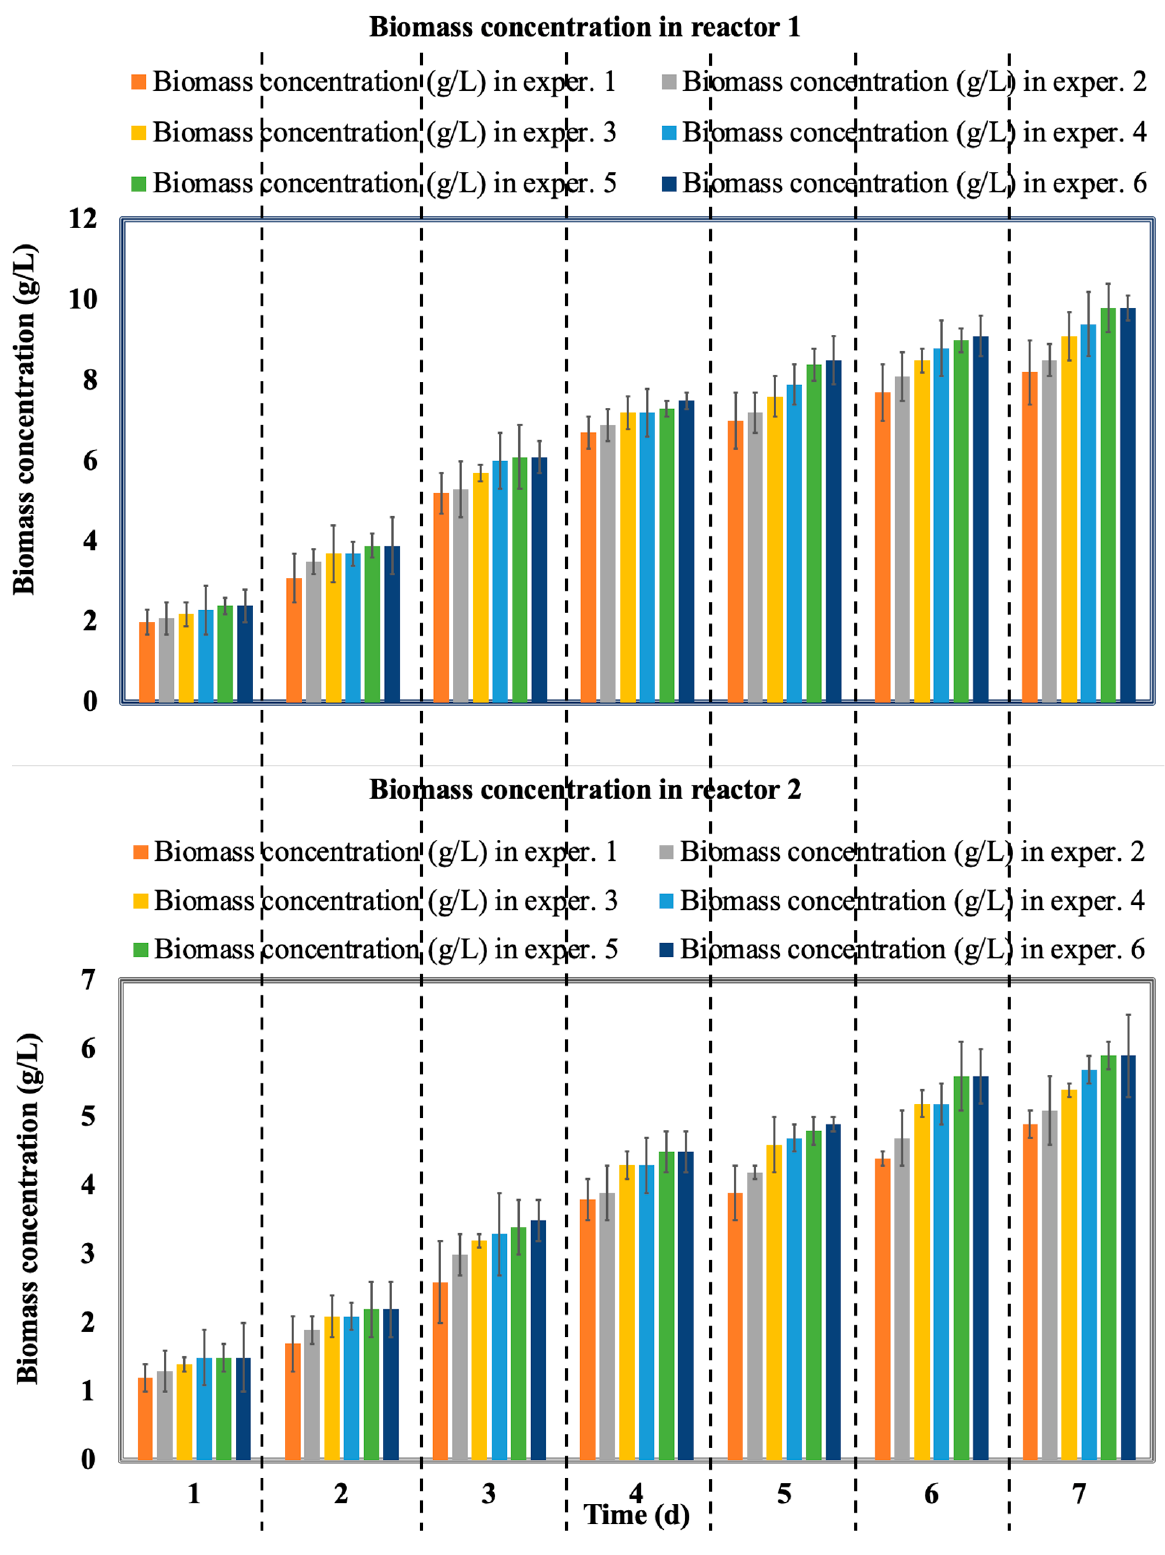
Figure 3. The evolution of biomass concentration (mg dry weight/L) in reactors 1 and 2 over time.